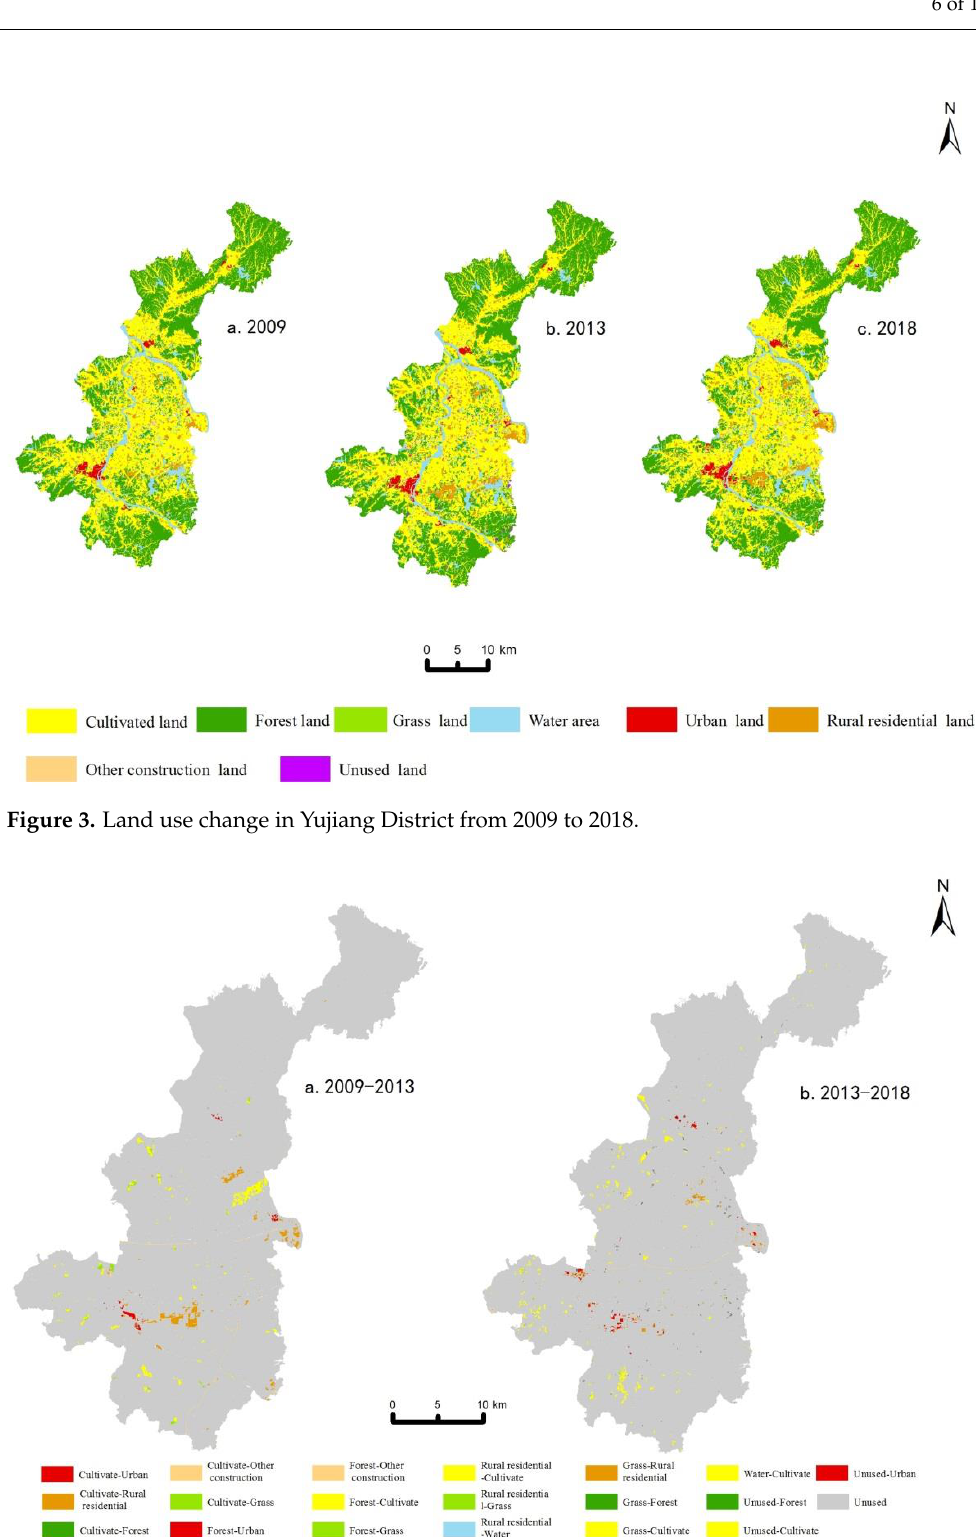
Figure 4. Spatial distribution of land use change in Yujiang District from 2009 to 2018.